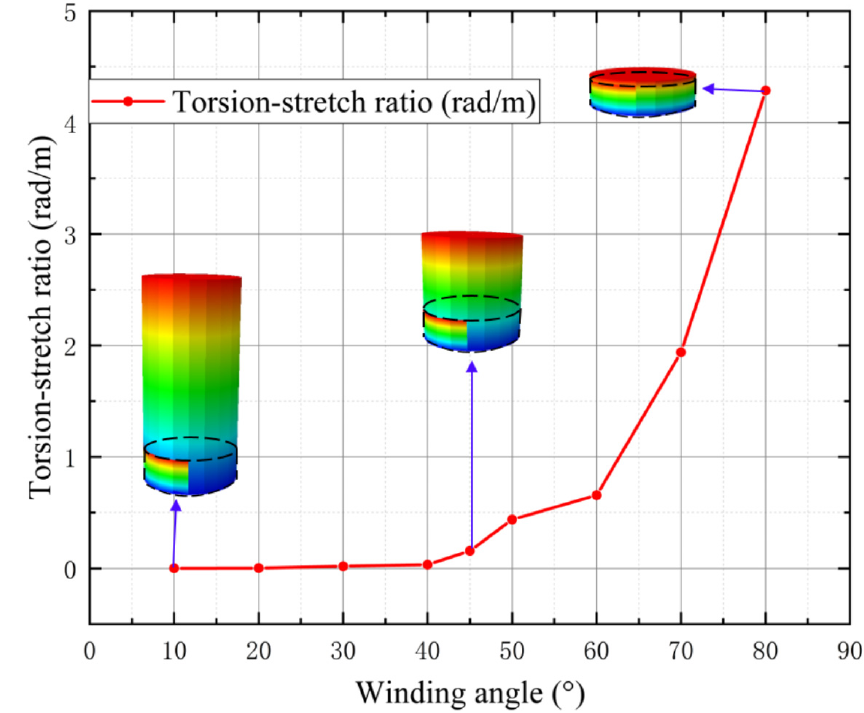
Figure 8. The torsion–stretch ratio diagram with different winding angles.